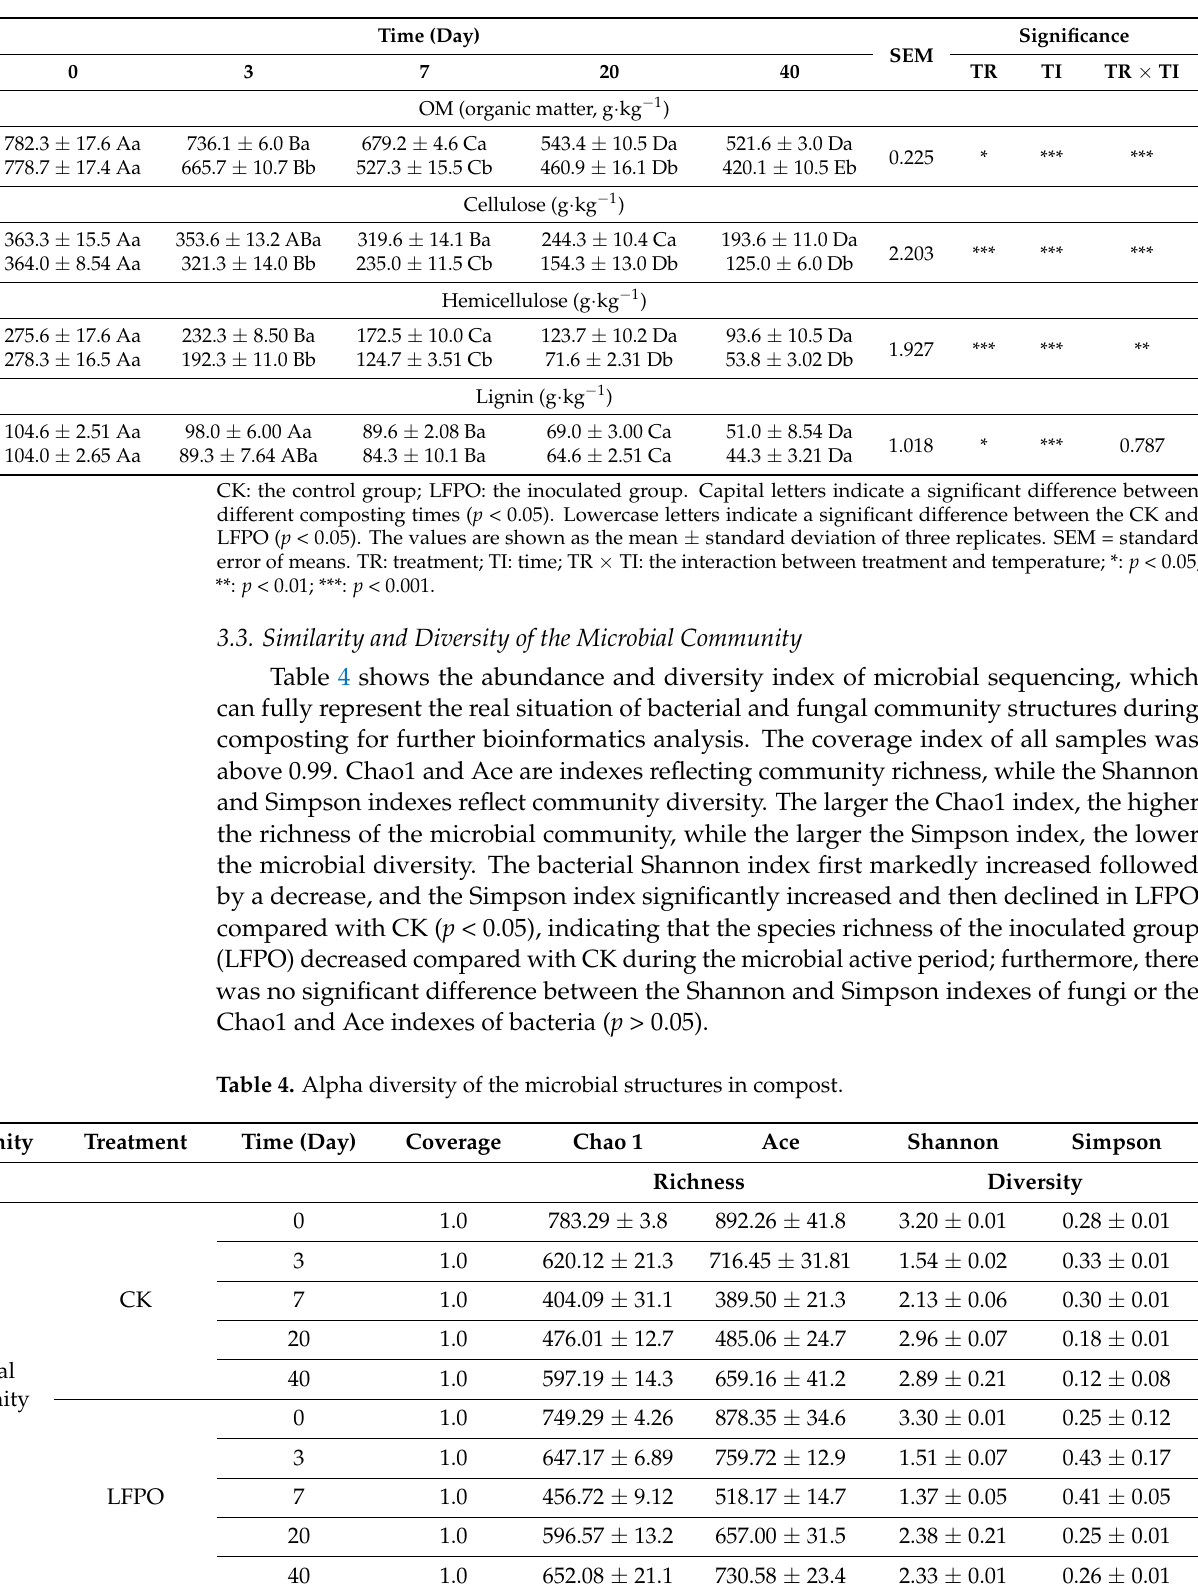
Table 3. Variations in the physical and chemical parameters.